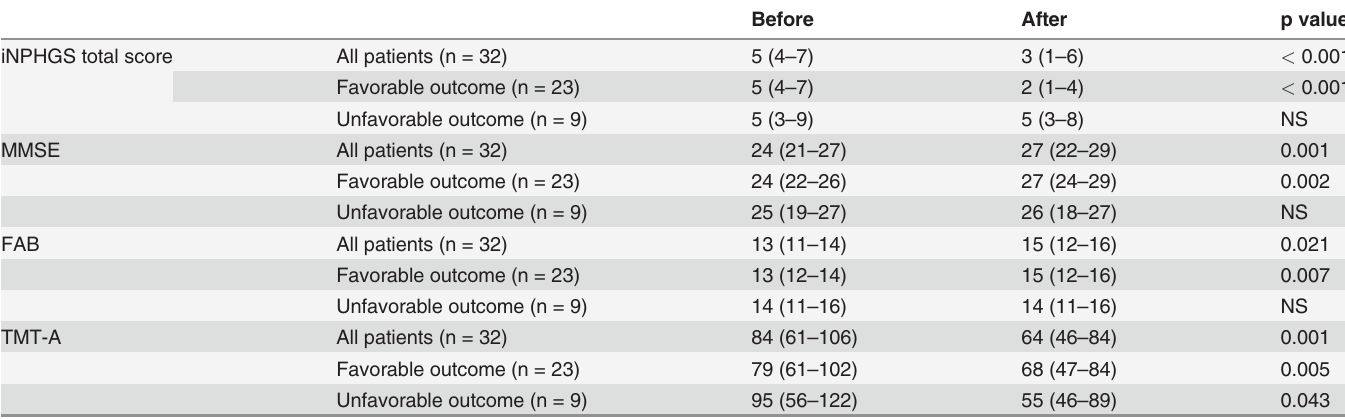
Before After p value